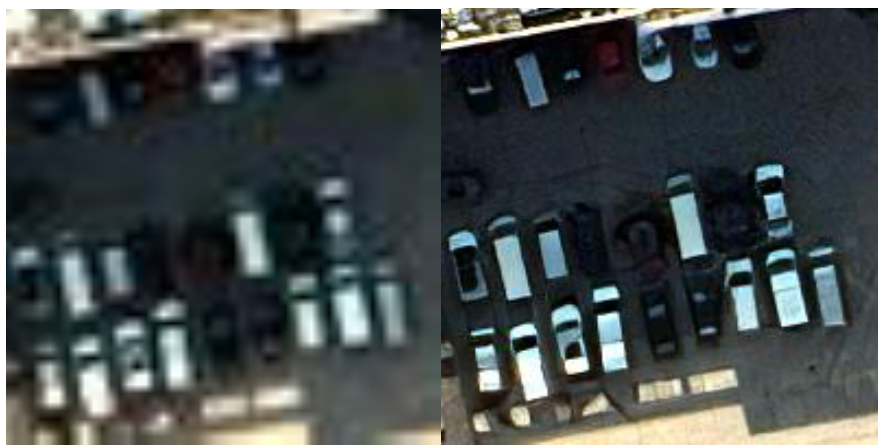
Road marking in the aerial